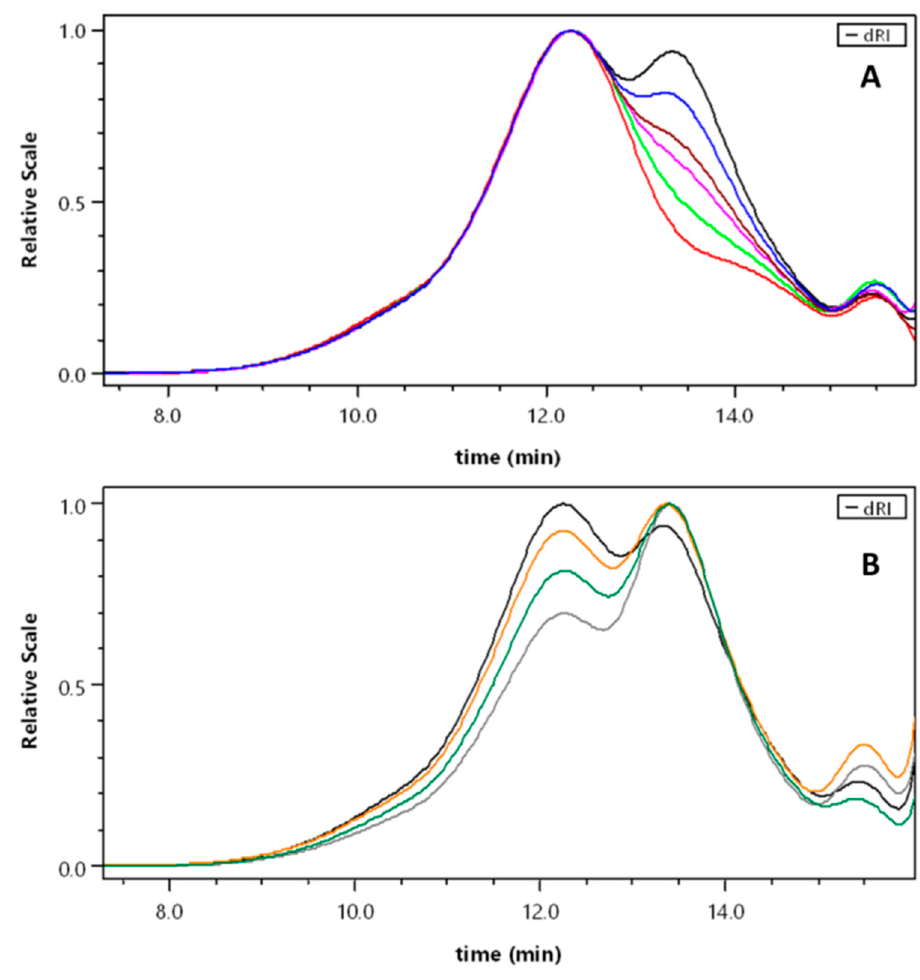
Figure 5. Loading of free PPO into micellar purified copolymer P4 (SEC, 80% MeOH / 20% acetate bu ff er, pH 6.5; column TSK 3000 Super SWXL)—SEC chromatograms: ( A ) 0 (red curve), 5 (light green curve), 10 (pink curve), 15 (brown curve), 20 (blue curve), 25 (black curve) wt % of loaded PPO; ( B ) 25 (black curve), 30 (orange curve), 35 (green curve), 40 (grey curve) wt % of loaded PPO.